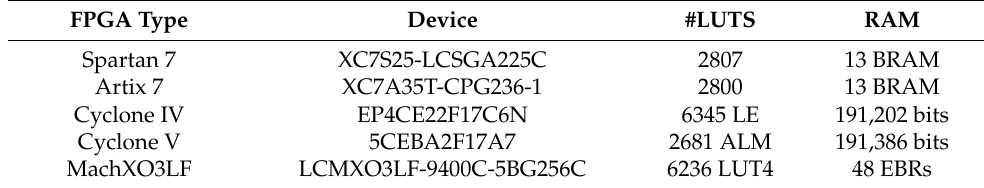
Figure 13. Minimal Dracon extended with two UARTs, Bluetooth connectivity and cryptographic support. Table 5. Minimal Dracon with DHT11 sensor and AES support implementation